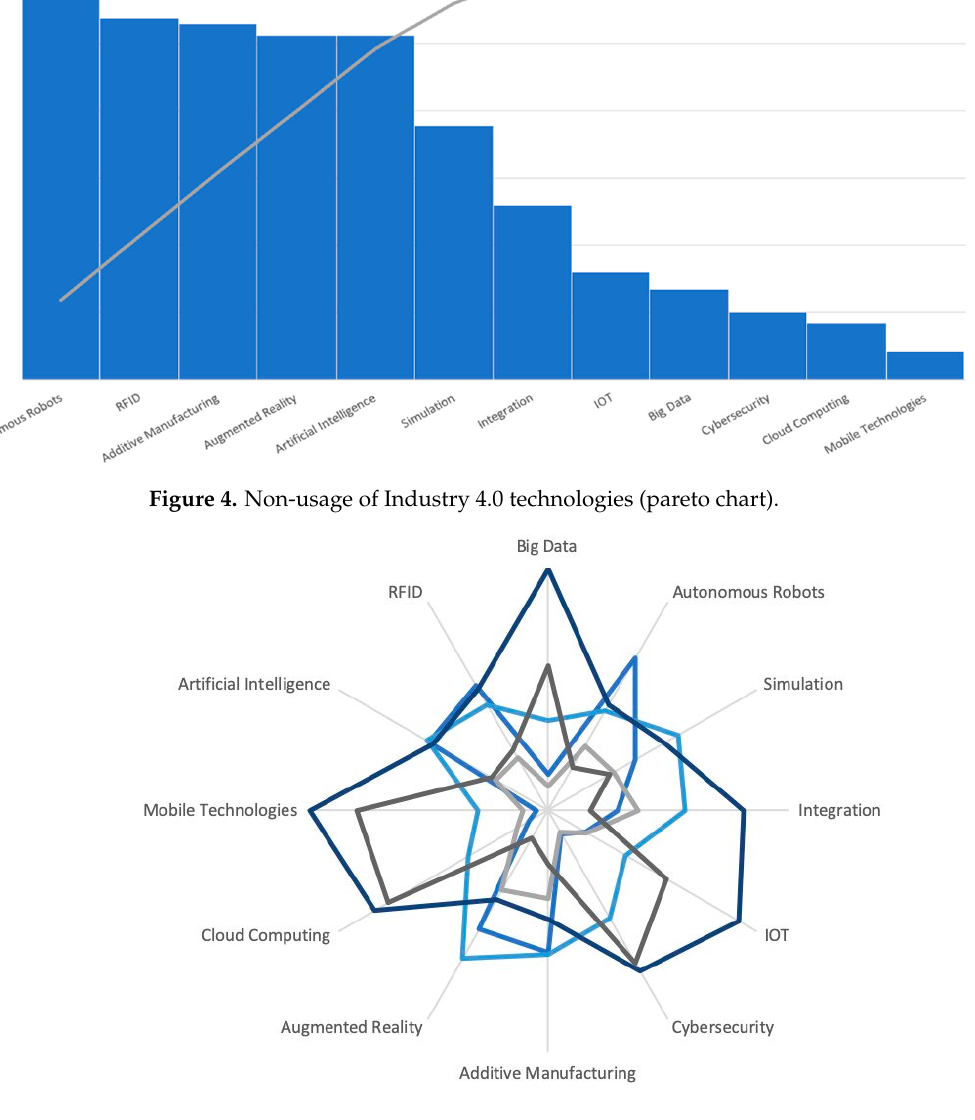
Figure 6. Industry 4.0 technologies (radar chart in terms of scales).